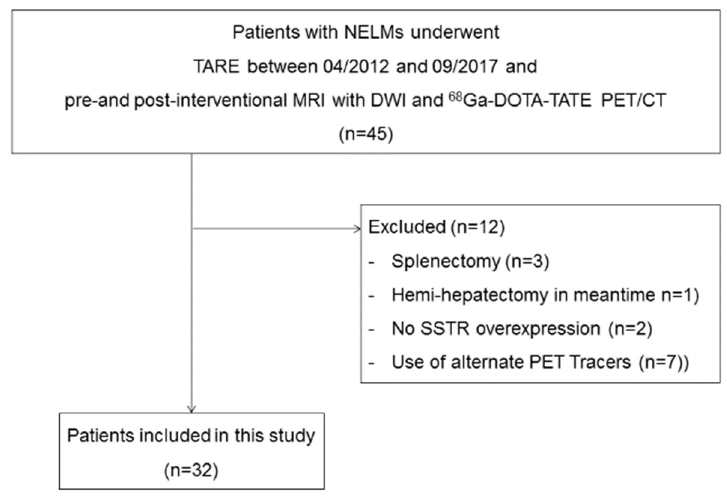
Figure 1. Inclusion and exclusion criteria.